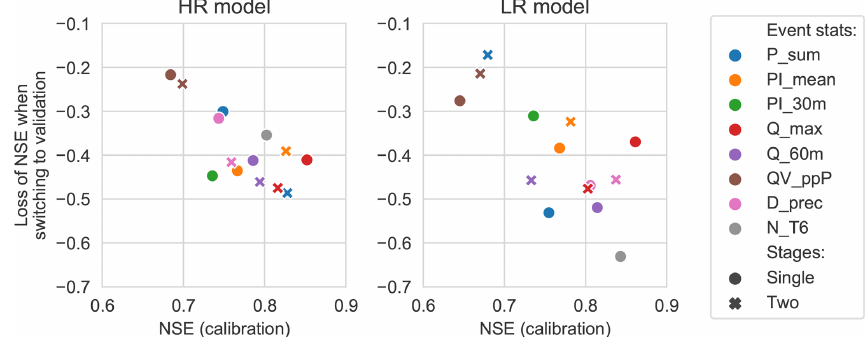
Figure 5. Loss of performance (NSE) when switching from calibration to